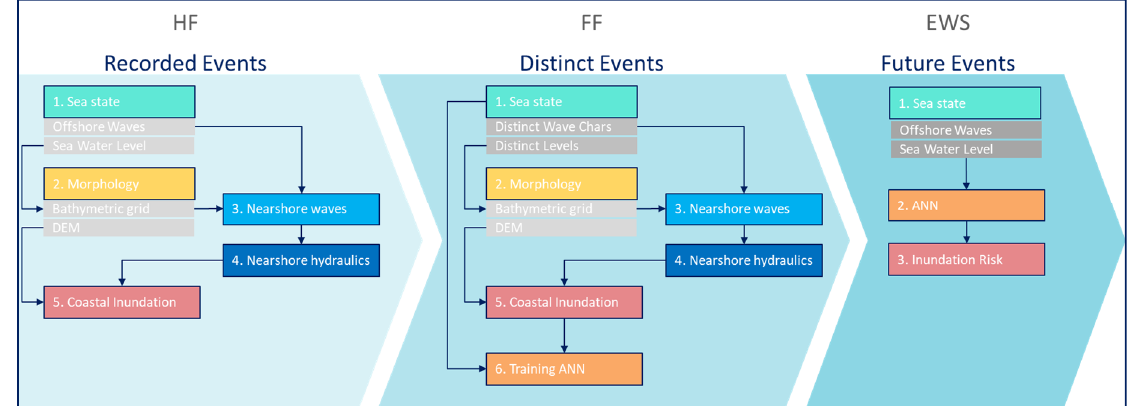
Figure 1. Flow chart of the proposed methodological approach to developing a coastal flood EWS and its frameworks (HF and FF).